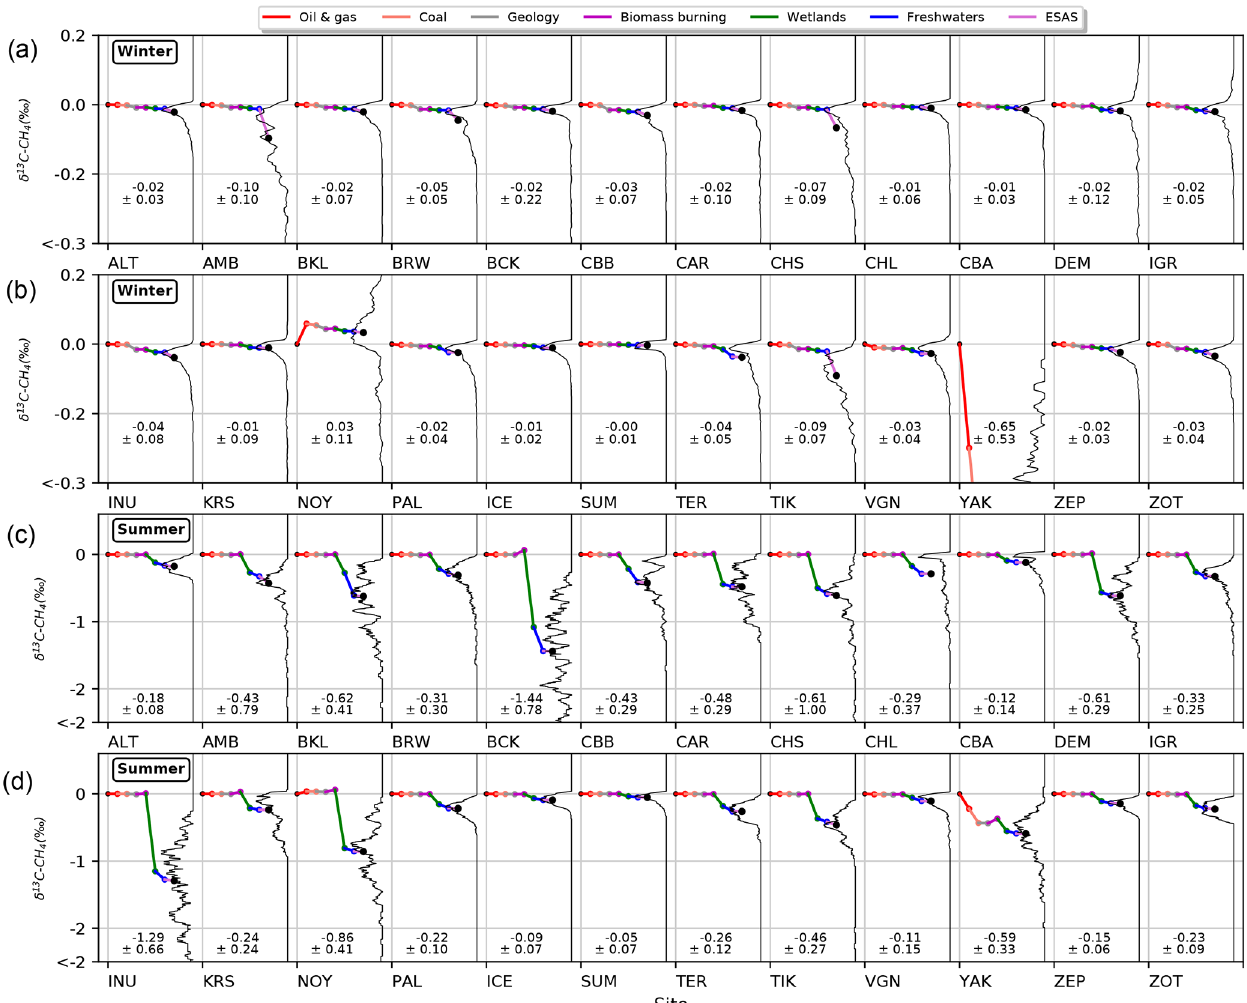
Figure 3. Winter (a, b) and summer (c, d) means of the direct contributions of the various northern high-latitude sources to the δ 13 C CH4 value (in ‰) simulated by CHIMERE at 24 sites in 2012. The frequency distribution of daily signatures at each site is overplotted with an arbitrary unit on the x axis, showing the simulated spread of the signal over the season. For each station and season, the number indicates the mean δ 13 C CH4 value (in ‰) associated with its 1 σ value. See Sect. 3.2 further